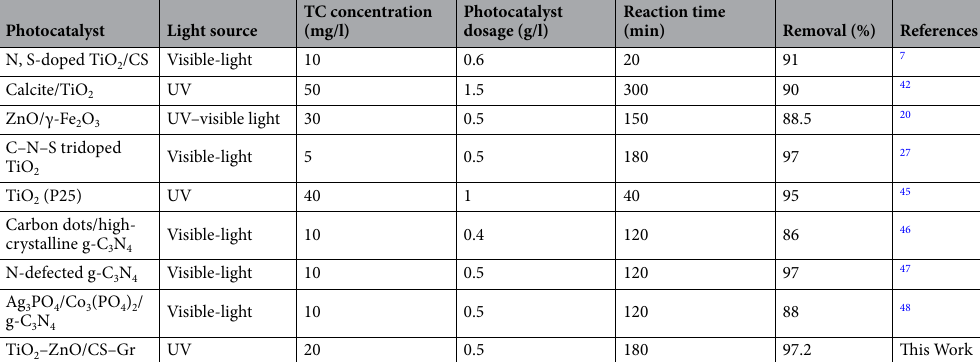
Table 5. Comparison of efficiencies for photocatalytic degradation of